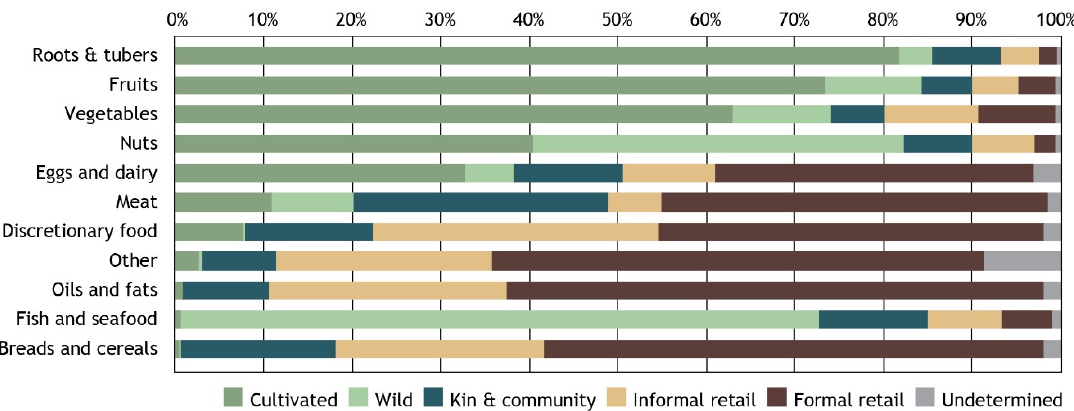
Figure 4. Proportion of total quantity of food groups acquired from different food environments in Solomon Islands na- tionally.